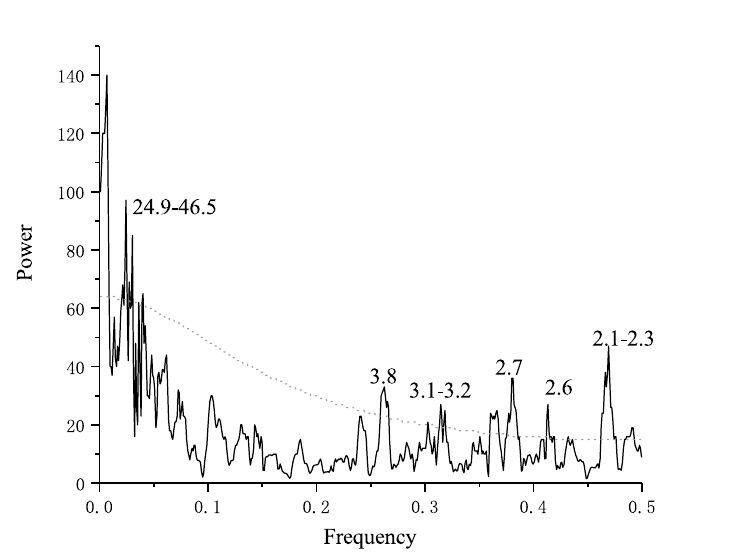
Figure 5. Multitaper method analysis of reconstructed scPDSI series. Dotted line denotes a 95% significant